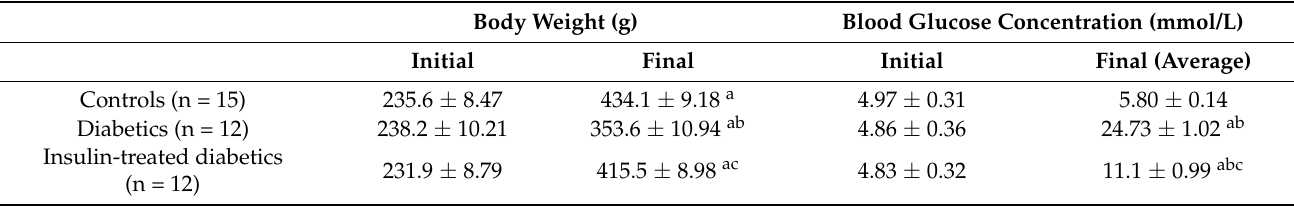
Table 1. Weight and glycemic characteristics of the experimental